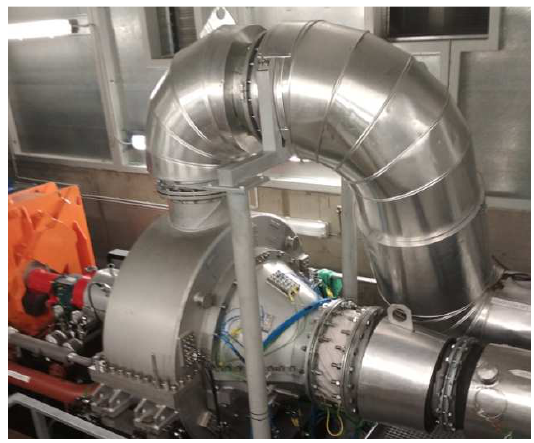
Fig. 1. Photo of the test rig for centrifugal compressor stages